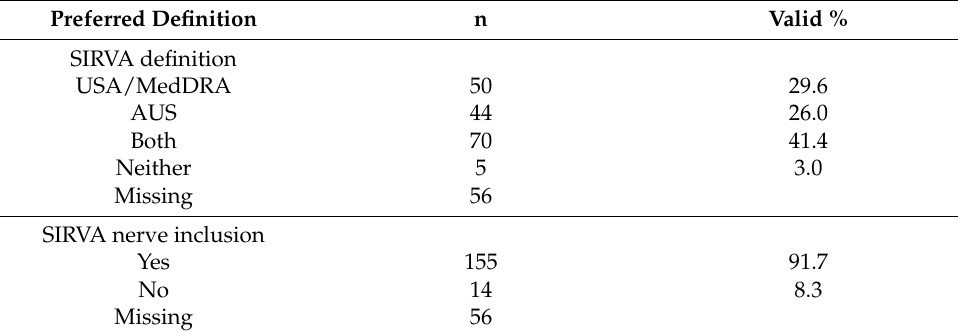
Table 8. Practitioner preferred opinion of diagnostic criteria (SIRVA